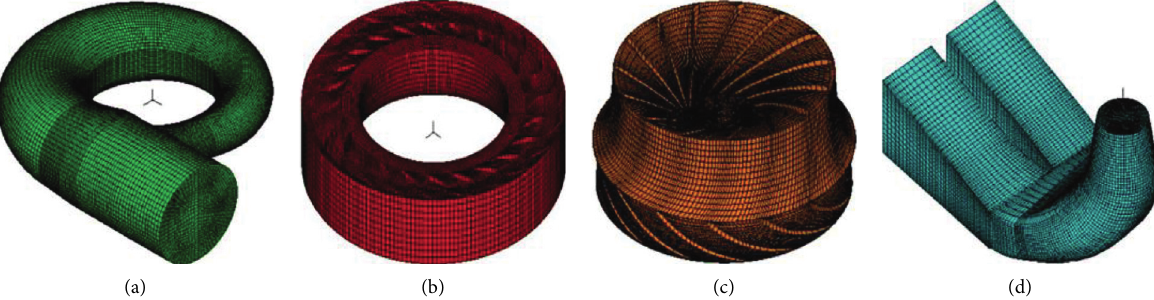
Figure 3: 3D structured grids for the fluid domain (Figure 3 is reproduced from Shuo Wang et al., 2019.). (a) Spiral case. (b) Stay and guide vane. (c) Runner. (d) Draft tube.